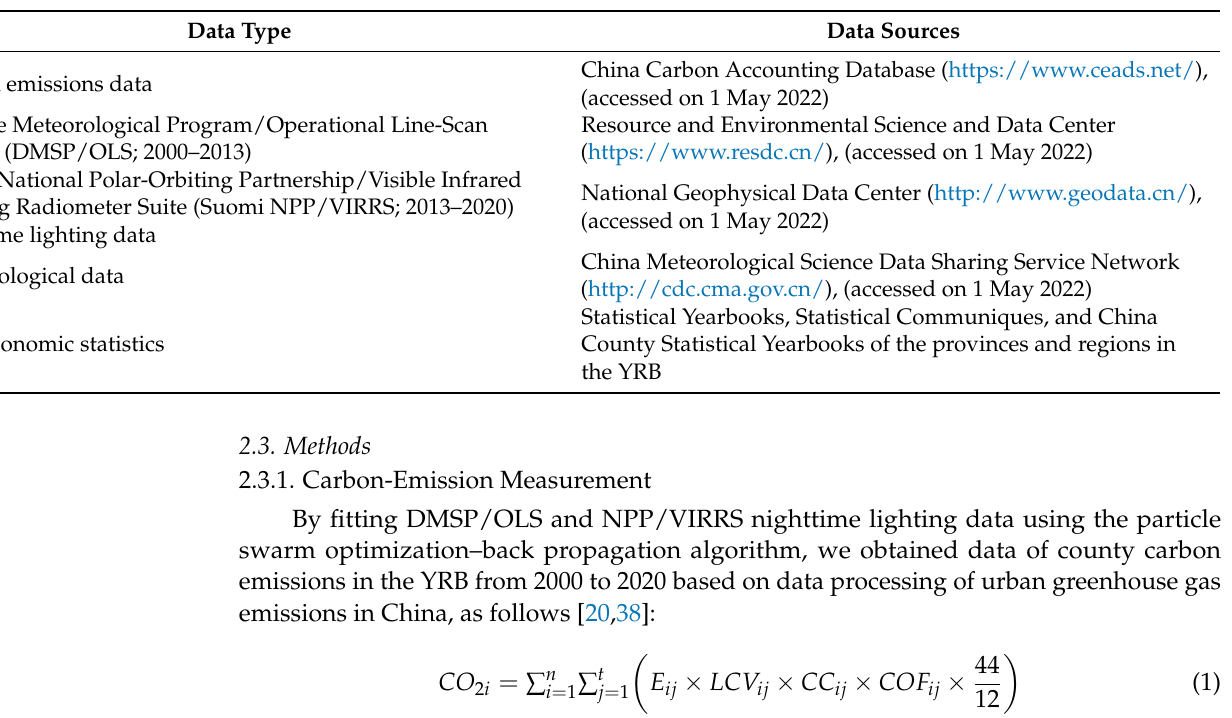
Table 1. Data type and